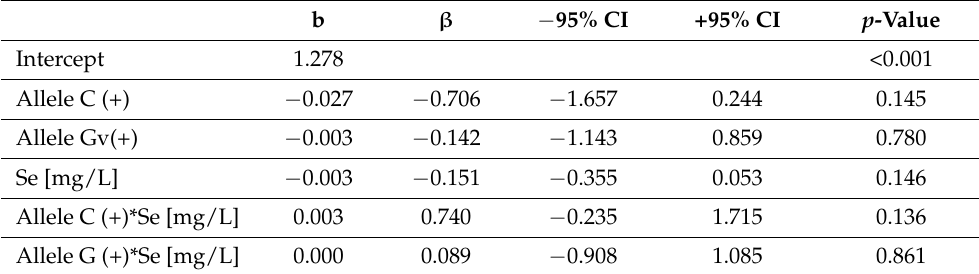
Table 6. Dependent variable: BMI (with moderation).